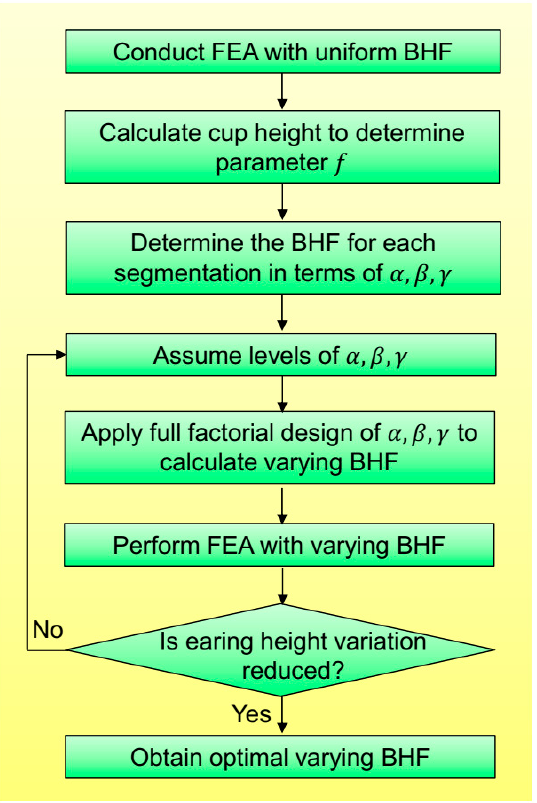
Figure 6. Algorithm for determination of optimal varying BHF with full factorial design of α , β , γ based on the analytical model by using the FE simulation.